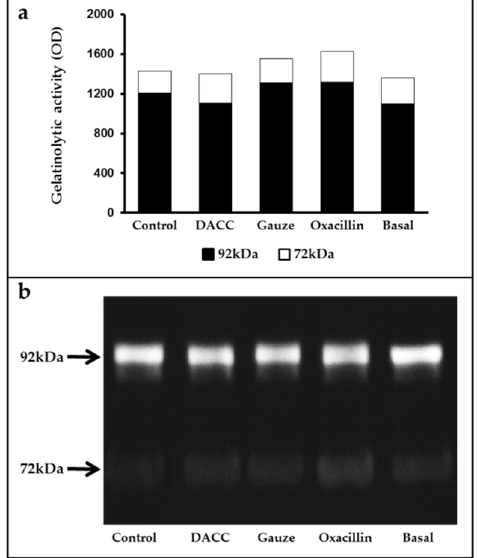
Figure 4. Average gelatinase activity derived from two independent experiments: ( a ) Black bars correspond to 92 kDa and white bars to 72 kDa species. The basal term refers to the conditioned medium from non-unstimulated eukaryotic cultures; ( b ) Gelatinolytic activity in the supernatants of fibroblast and macrophage co-cultures, as determined by gelatin zymography and polyacrylamide gel electrophoresis.